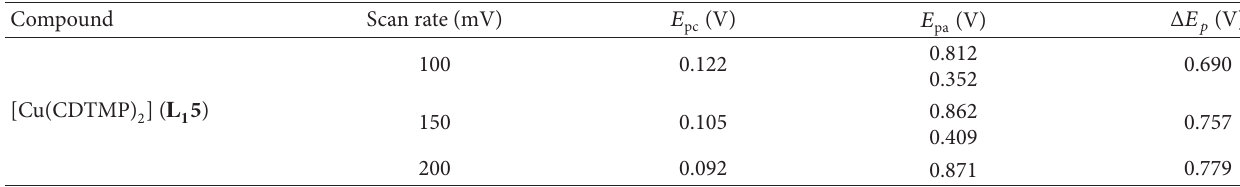
] at different scan rates. 2